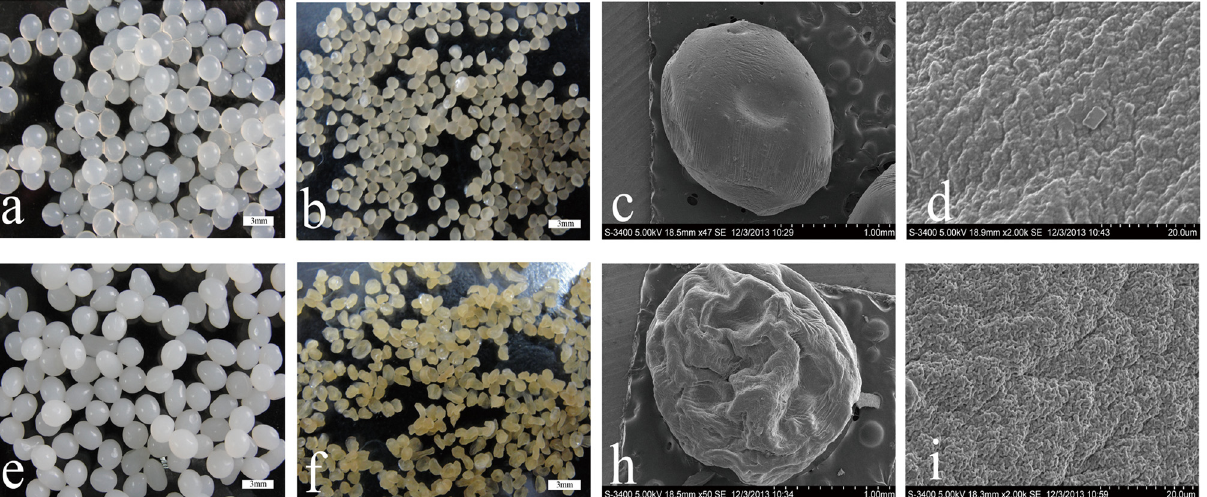
Fig 4. Digital photographs of SA gels (a, b, c, d) and SA-PGA gels (e, f, h, i).